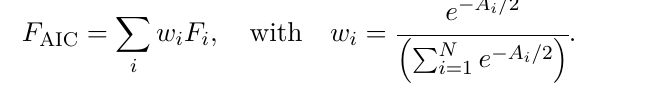
Figure 11 . Results of the AICc prescription applied to Re Y z/a ∈ [2 , 8] , where our matrix element fitting systematic (3.8) is considered. (Left) The AICc averaged leading-twist valence helicity quark PDF (purple) and model-averaged x -space distribu- tions corresponding to an O ( a/ | z | ) discretization (orange) and O effects. Comparisons continue to be made with select global analyses. (Right) Histogram of AICc weights associated with all models considered in the data